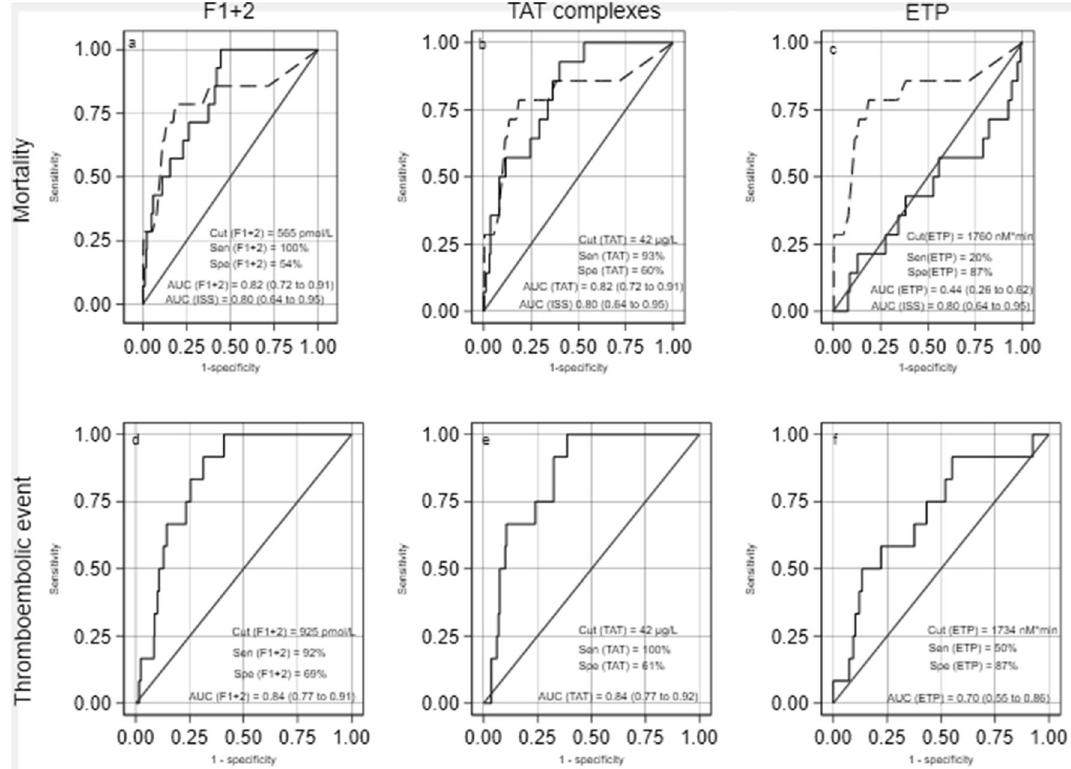
Figure 3. Reciever operating characteristic (ROC) curve analysis of the ability of admission levels of F1+2, TAT complexes and ETP to separate dying/surviving and thromboembolic events 30 days after multiple trauma. A–C: Separation of dying/surviving patients. D–F: Separation of thromboembolic events. Area under the curve (AUC) as well as sensitivity (Sen) and specificity (Spe) at defined cut points (Cut) by youden index shown. Solid lines indicate F1+2, TAT complex levels and ETP. Punctured lines indicate ISS score. The AUC of F1+2, TAT complexes and ETP to separate dying from surviving patients was compared with ISS score. F1+2 versus ISS ( p = 0.76), TAT complexes versus ISS ( p = 0.80) and ETP versus ISS ( p = 0.02). The Youden Index identified a sensitivity of 79% and specificity of 81% for ISS at a cut point of 17.5. Abbreviations: ETP endogenous thrombin potential, F1+2 prothrombin fragment F1+2, ISS Injury Severity Score, TAT Thrombin- antithrombin complex